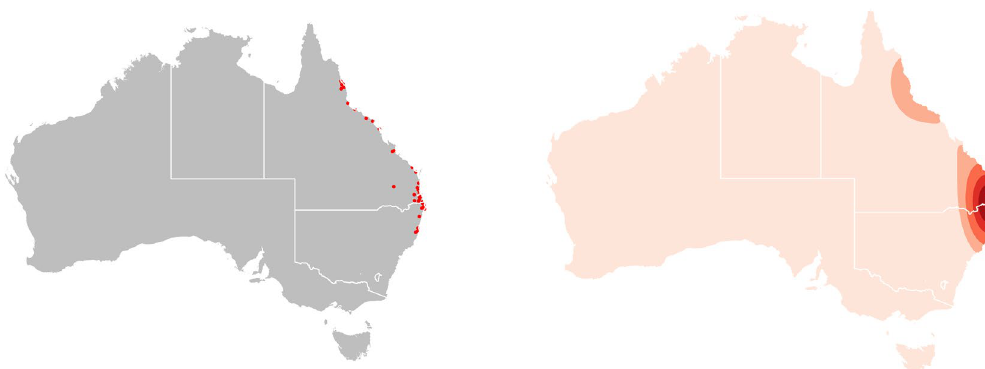
Figure 1. Hendra virus spillover. Left panel: Distribution of Hendra virus spillover incidents to horses in Queensland and New South Wales, Australia, between 2000 and 2015. Right panel: Kernel density estimate (KDE) of Hendra virus zoonotic transmission events. The KDE is mapped with Australian state boundaries. The white borders show the states used in the subsequent flying fox ecological niche analyses. All maps created in R (v. 3.3.1) 42